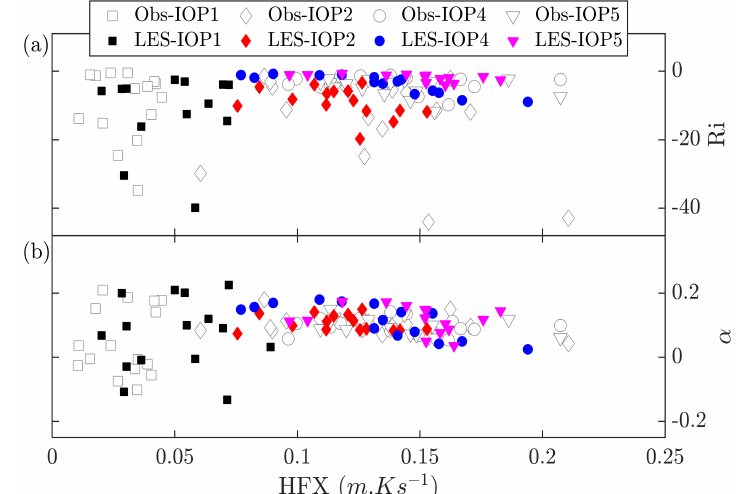
Figure 9. The 10-min averaged ( a ) Richardson number ( Ri ) and ( b ) Shear exponent ( α ) calculated based on the wind and temperature readings at 8 and 60